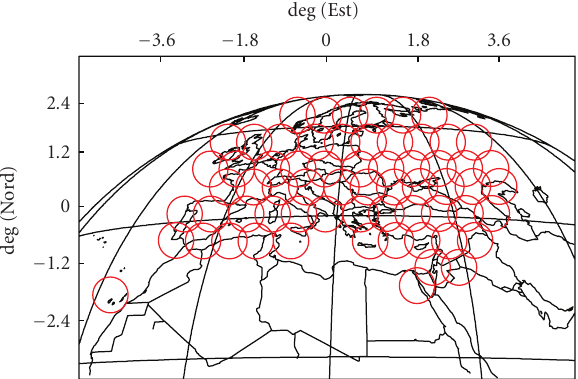
Figure 3: European multibeam coverage in a 1 :4 frequency re-use scheme from a geostationary satellite.